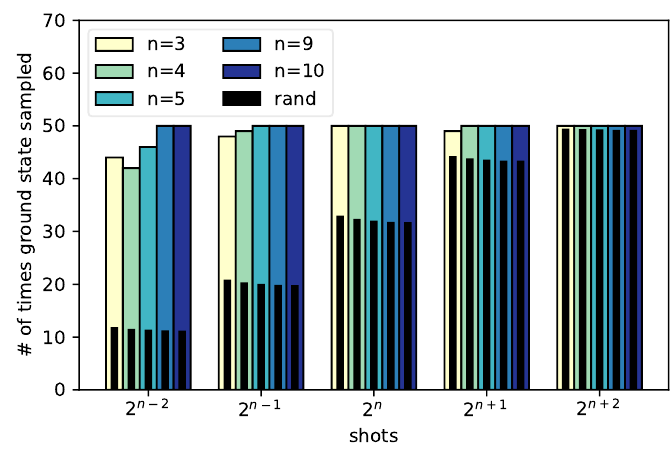
Figure 5: In this bar graph, we collect the number of experiment instances in which we observe the exact ground state bitstring, at least once (on the Y axis) for n ∈ { 3,4,5,9,10 } . Each n has 5 problem instances, which is repeated 10 times for a given shot value. We compare the QAOA shot-noise simulator experiments (color- coded with the number of binary variables, n ), with the results one would expect randomly sampling from a uniform distribution shots times (black bars, labeled with rand, x-axis positioning corresponding to its colour-labeled partner). The QAOA data in this figure comes from sampling the circuit with optimized angle sets γ ∗ and β ∗ , after acquiring them by optimizing for a QAOA depth of p = 3 and a budget of 200 iterations, as described in Section